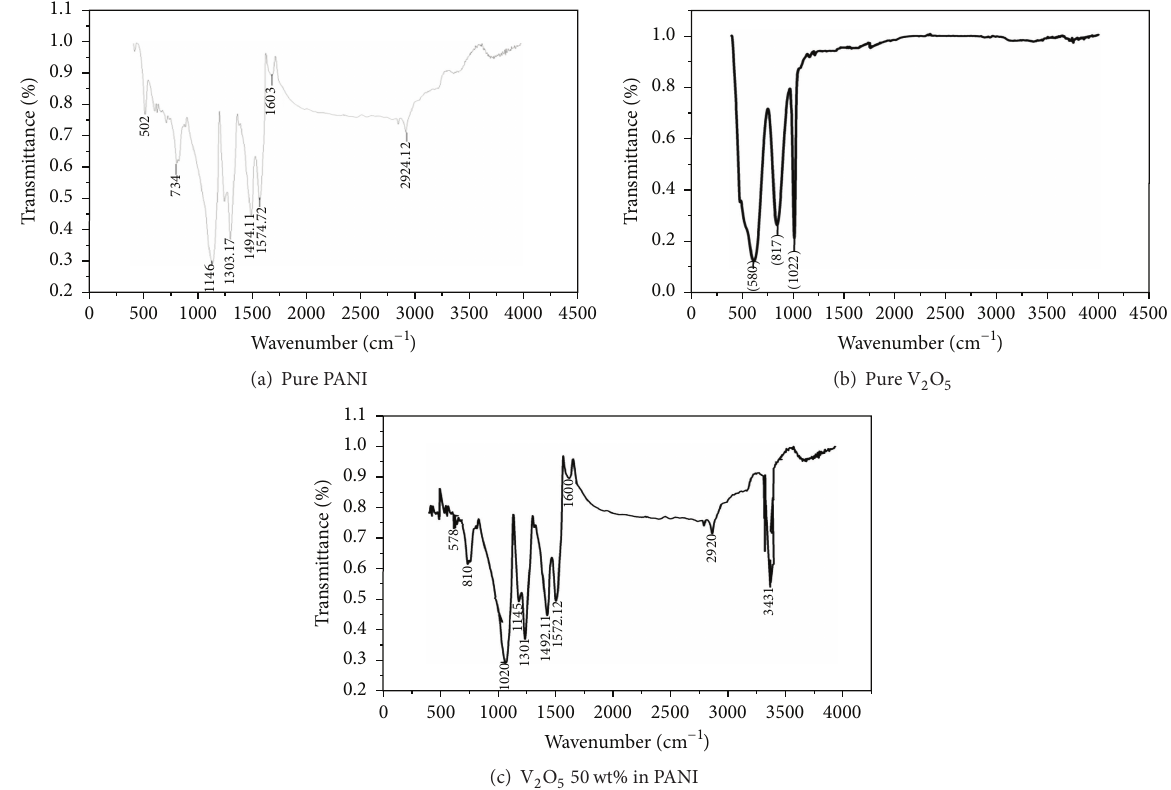
Figure 1: (a) FTIR spectrum of PANI. (b) FTIR spectrum of V 2 O 5 nanoparticle. (c) FTIR spectrum of 50 weight% of V 2 O 5 in PANI (V 2 O 5 /PANI